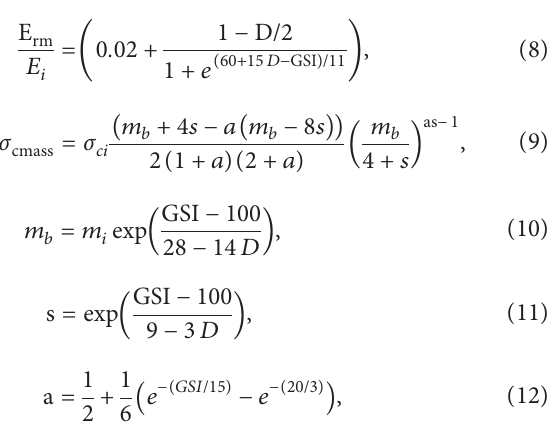
Figure 17: Numerical calculation model.